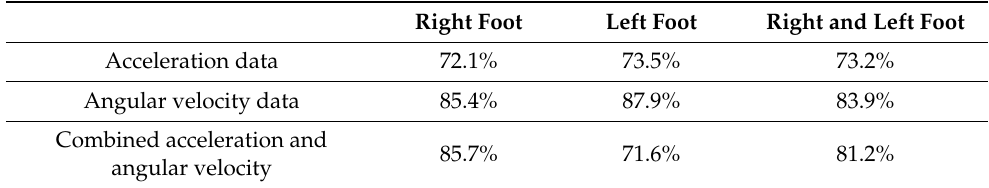
Table 2. Overall accuracy of the acceleration, angular velocity and both combined on each foot individually and both together. Values have been taken from the confusion matrices.